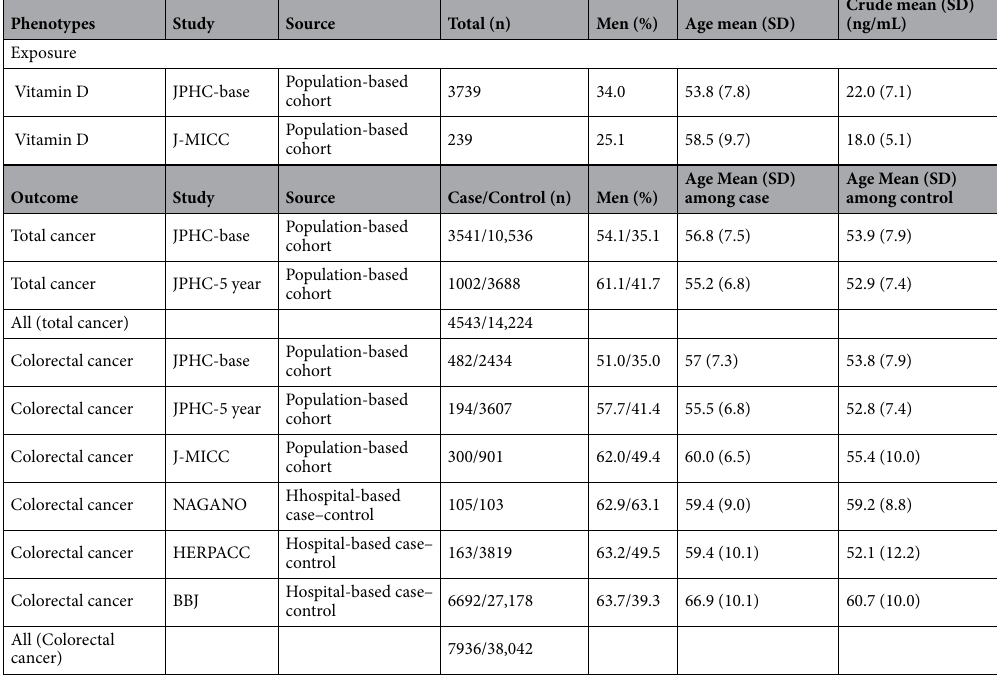
Table 1. Baseline characteristics of participants. JPHC Japan public health center-based prospective, J-MICC Japan multi-institutional collaborative cohort, HERPACC Hospital-based epidemiologic research program at aichi cancer center, BBJ BioBank Japan.